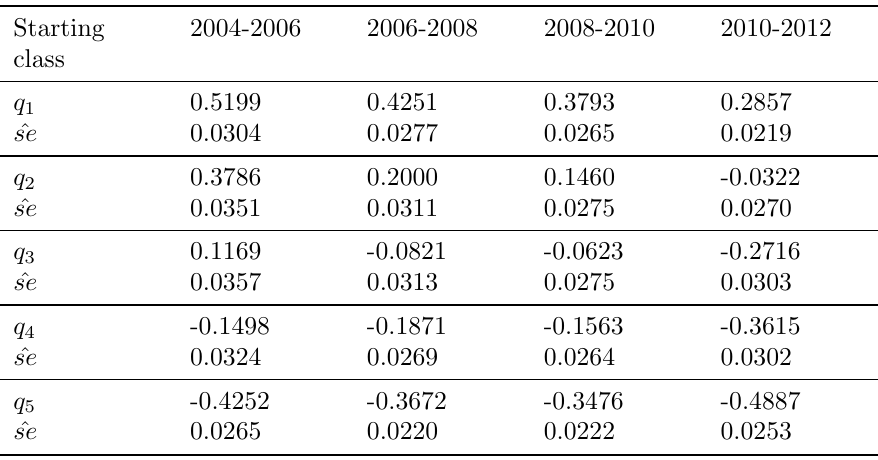
ˆ I dir values evaluated on families moving from different income classes.